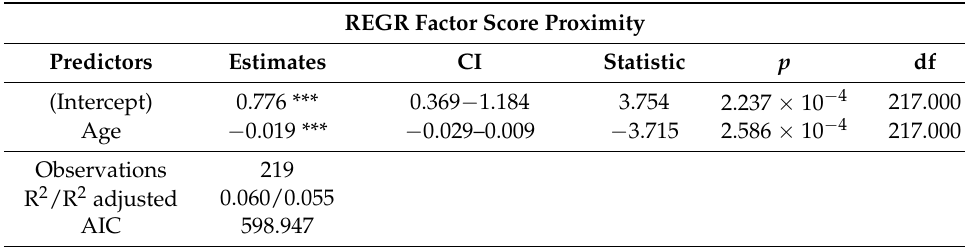
Table 11. Final regression model for Proximity.